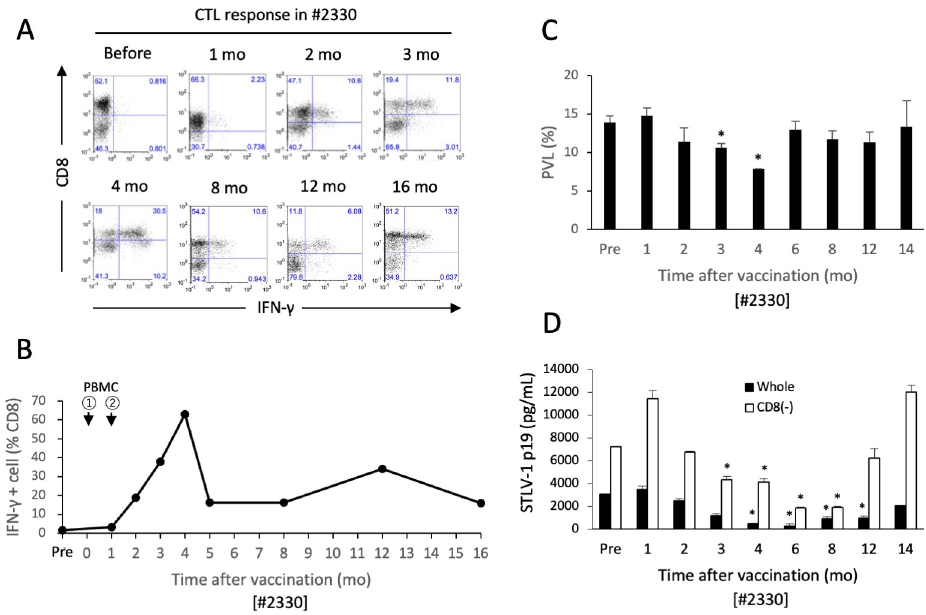
Fig 5. Vaccination of monkey #2330 with autologous PBMCs. Monkey #2330 was subcutaneously inoculated twice with 3 × 10 6 MMC-treated autologous CD8 + cell-depleted PBMCs that had been cultured for 3 days, with doses spaced 1 month apart. A, B. CTL responses against ILT-2330 in PBMCs were analyzed by cytokine flow cytometry as described in the Methods, and the representative results at indicated time points after vaccination ( A ) and the kinetics of the percentages of IFN- γ -producing CD8 + STLV-1-specific CTLs ( B ) are shown. The arrows indicate the time points of vaccination. C. STLV-1 PVLs in the PBMCs taken from monkey #2330 at the indicated time points are shown as the mean and SD of duplicate or triplicate samples. D. STLV-1 p19 concentrations in the culture supernatants of the unfractionated (closed bar) or CD8 + cell-depleted (open bar) PBMCs from monkey #2330 were measured by ELISA. The sample taken before vaccination was a 5-day culture supernatant, whereas the other samples were 7-day culture supernatants. The values indicate the mean and SD of duplicate samples. � p < 0.05.